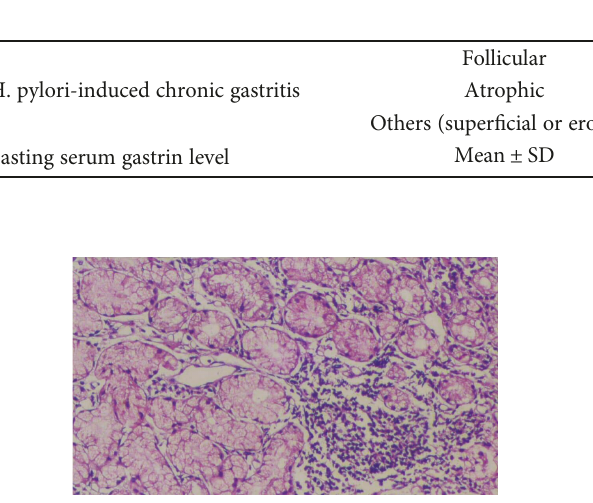
Table 3: Histopathological patterns of chronic gastritis and the fasting serum gastrin level among H. pylori positive patients.